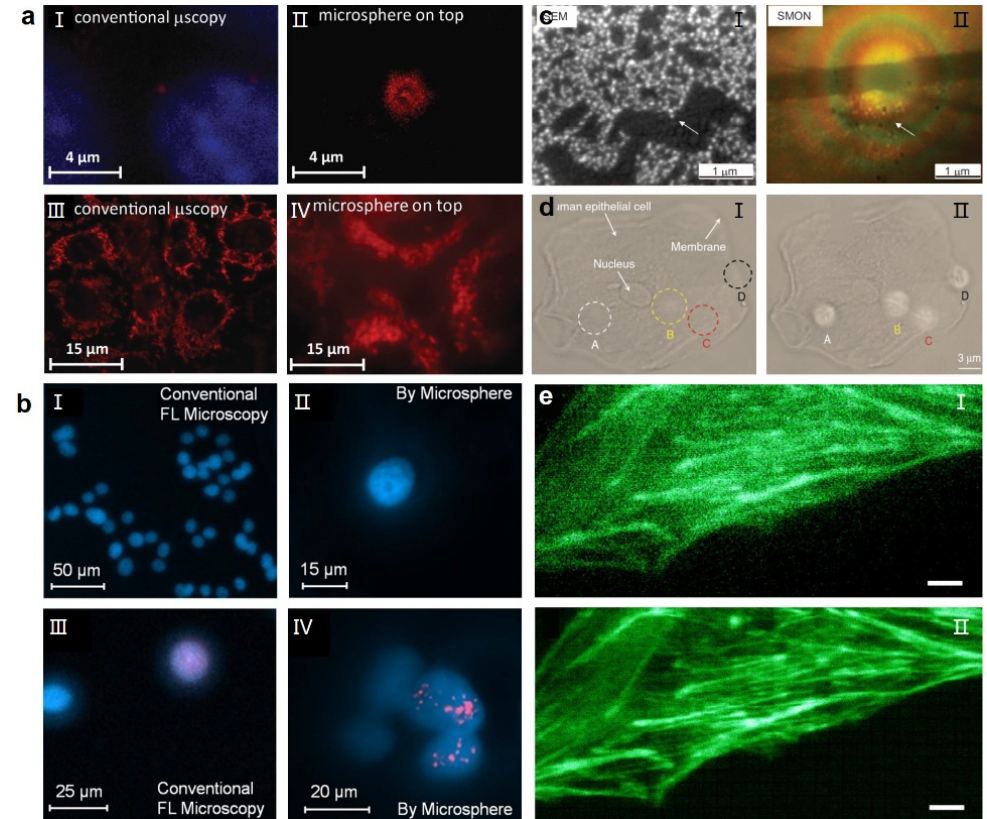
Figure 8. Super-resolution imaging of organisms. ( a ) Imaging of centrioles (I–II) and mitochondria (III–IV) of mouse hepatocyte lineage cells using conventional fluorescence microscopy and micro- sphere superlenses; ( b ) Optical images of cells without (I) and with (II) a microlens, and fluorescence images of cell nuclear double-stranded DNA imaging without a microlens (III) and with a micro- sphere superlens (IV); ( c ) SEM images of adenovirus by BaTiO 3 microspheres under white light (I) and imaging under BaTiO 3 (II).; ( d ) Imaging of the bilayer structure of the fibrous cytoskeleton and cell membrane without a microlens (I) and with a cellular lens (II); ( e ) Fluorescence imaging of C2C12 cells (I) and enhanced images with 56 μ m diameter microsphere superlenses (II).